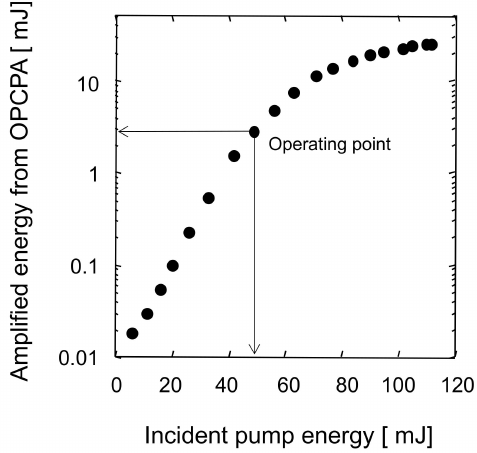
Figure 4. Measured output energy of the OPCPA pre-amplifier for broadband amplification as a function of the energy of the pump